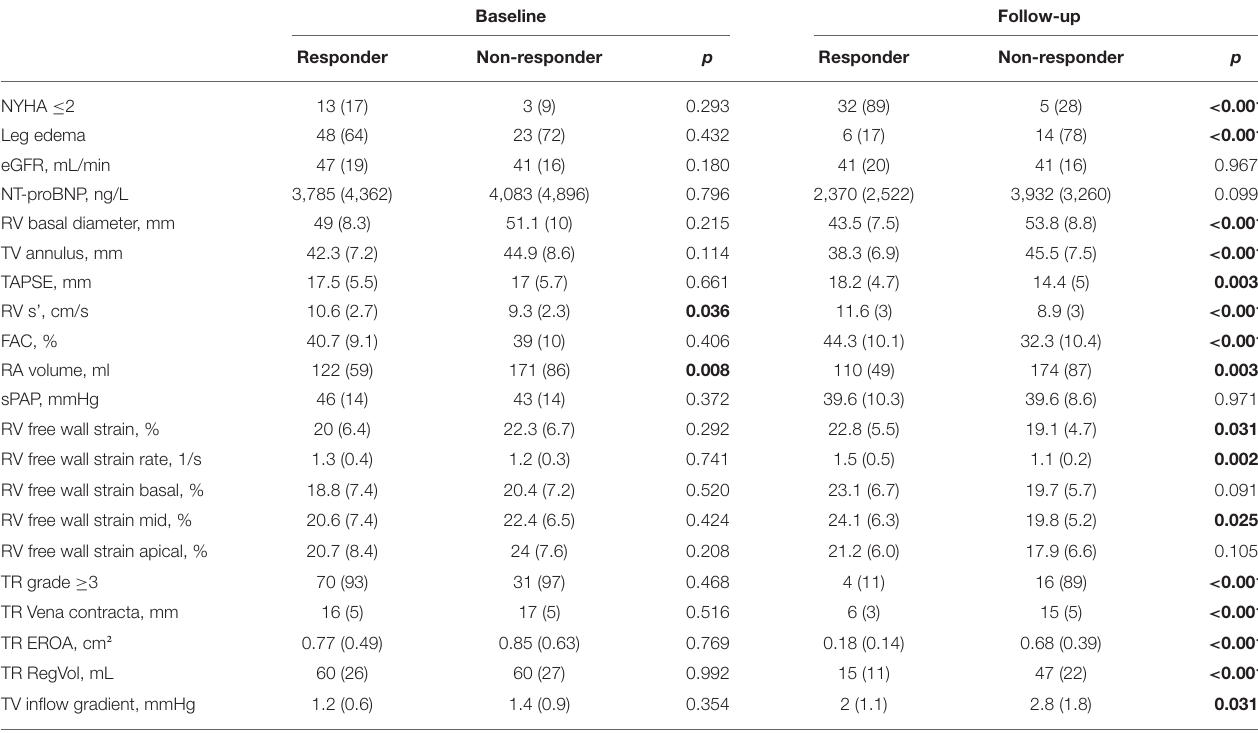
TABLE 6 | Comparison of responder and non-responder data divided by baseline and follow-up examination. Baseline Follow-up Responder Non-responder p